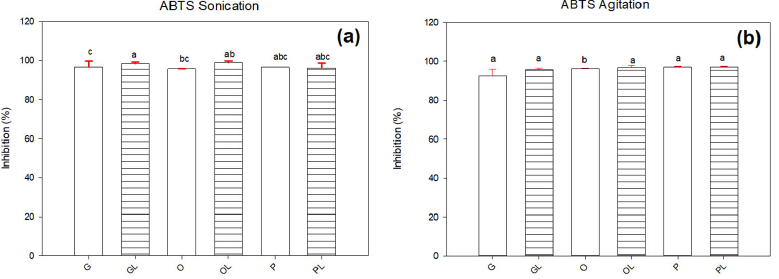
Figure 4. ABTS radical inhibition in samples subjected to ( a ) sonication and ( b ) agitation. Letters (a–c) represent significant differences between samples.